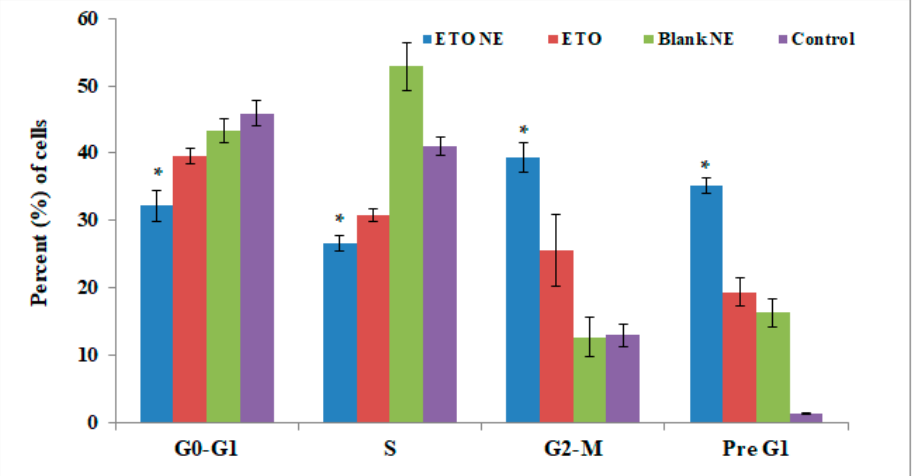
Figure 8. Flow cytometric analysis of ETO NE, free ETO, blank NE, and control group on cell cycle distribution in A549 cells. Data are expressed as (mean ± SD, n = 3), where * denotes significant difference between ETO NE ( p < 0.05) vs. free ETO, blank NE and control group.